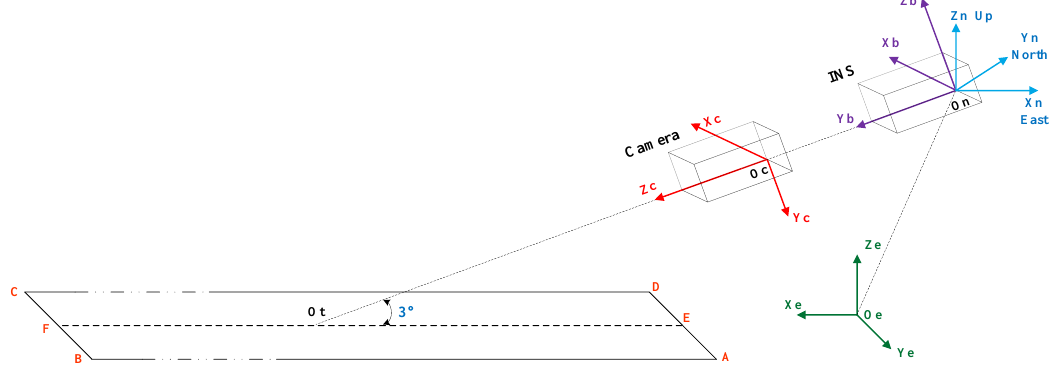
Figure 4. Reference frames and runway model